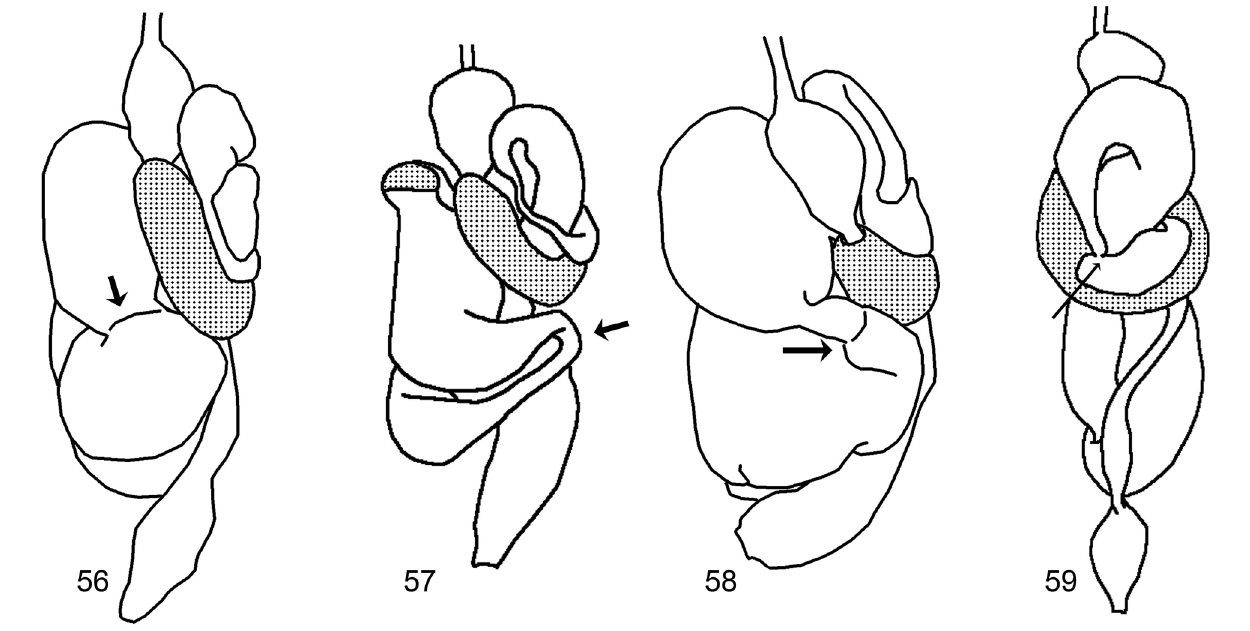
Figs 56–59. Worker gut: 56- left view of Embiratermes neotenicus (arrow: P1-P3 wide connection); 57- left view of Silvestritermes lanei (arrow: dorsal loop); 58- left view of Cyrilliotermes sp. (arrow: P1-P3 connection); 59- dorsal view of Acangaobitermes krishnai (arrow: subapical P4 connection , figures not to